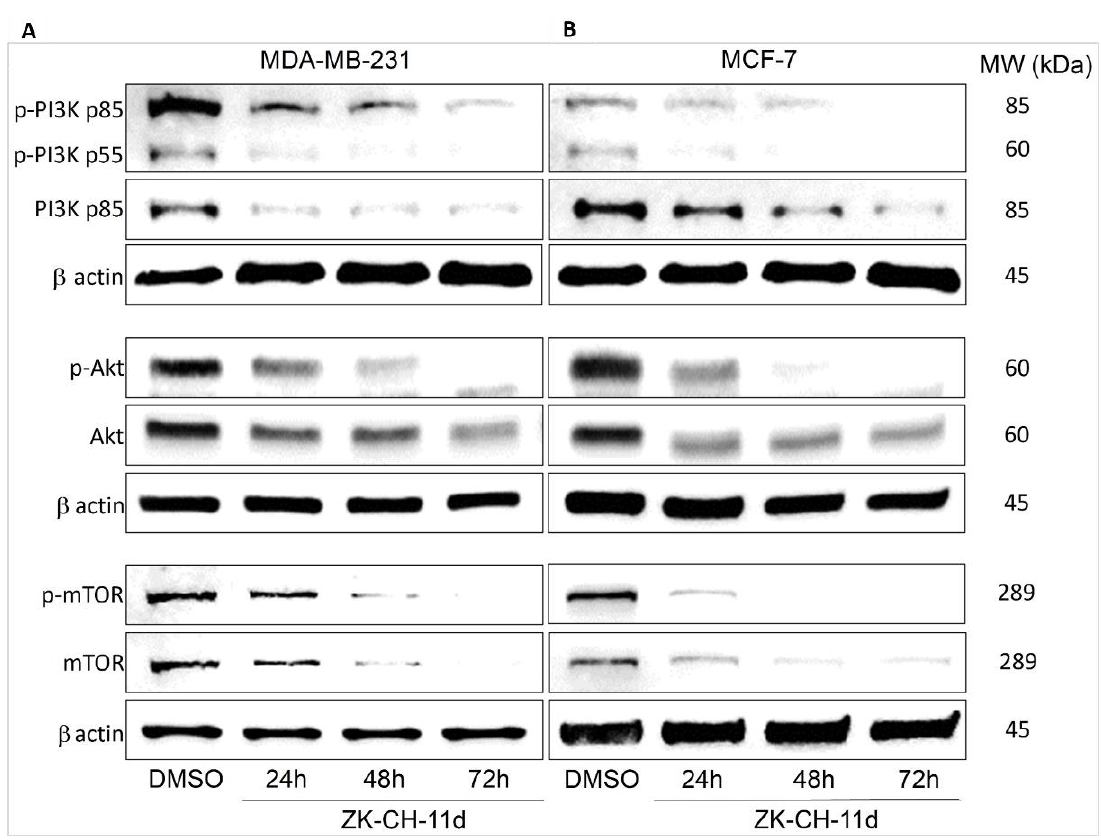
Figure 15. Western blot analysis of PI3K-Akt-mTOR signaling pathway in MDA-MB-231 ( A ) and MCF-7 ( B ) cells after treatment with chalcone ZK-CH-11d for 24, 48, and 72 h of treatment.